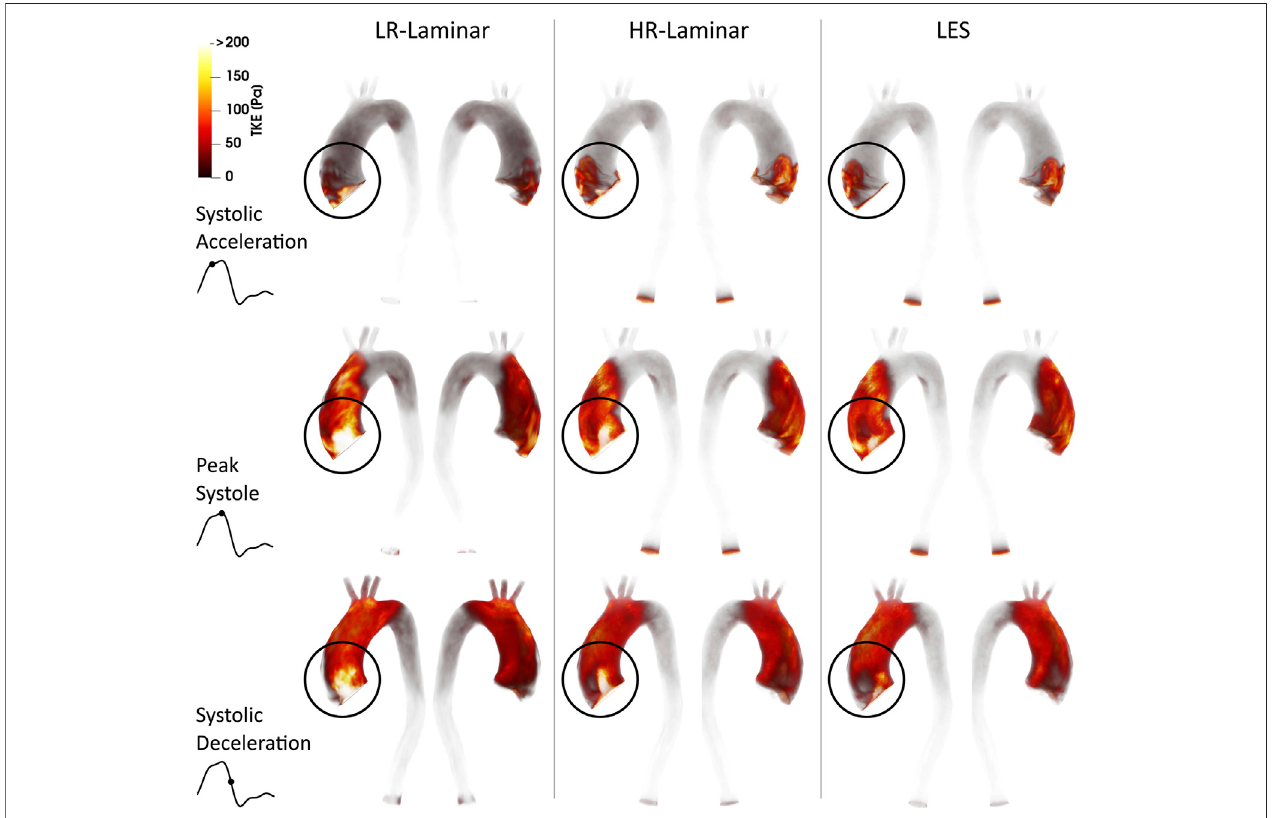
FIGURE 3 | Turbulence kinetic energy (TKE) volume renderings for LR-Laminar, HR-Laminar and LES simulations at three time-points. Top-to-bottom: systolic acceleration, peak systole and systolic deceleration. Locations of largest differences are circled.